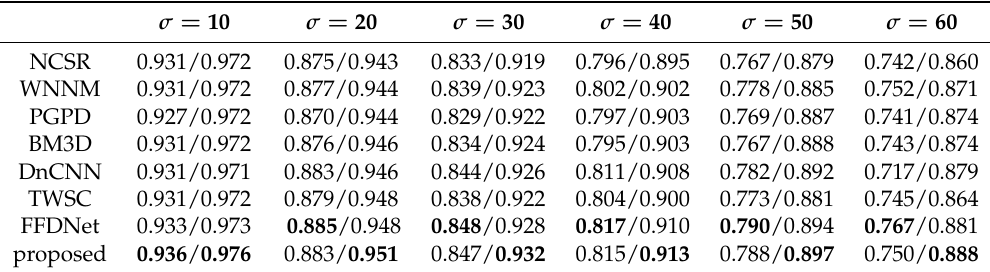
Table 3. Average SSIM/FSIM values obtained for the competing methods evaluated on commonly used test images with noise level σ = 10, 20, 30, 40, 50 and 60.